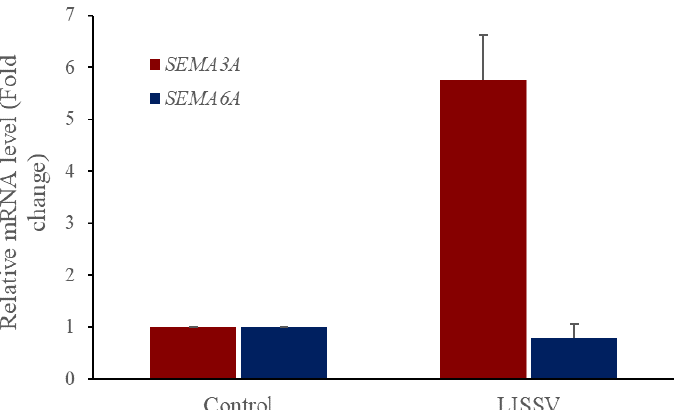
Figure 11. The changes of specific markers in human umbilical-cord-derived mesenchymal stem cells by low-intensity sub-sonic vibration and recombinant PLXNA4 protein treatment using FACS analysis. Cells were harvested 3 days after each treatment. PE-conjugated anti-CD73 and PE- conjugated anti-CD105 were used. ( A , D ) Control. ( B , E ) LISSV treatment. ( C , F ) 2 µ g/mL recombinant PLXNA4 protein treatment.